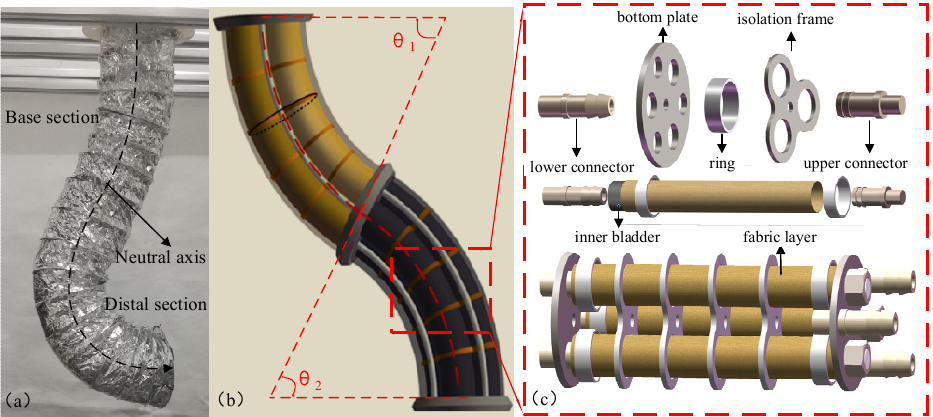
Figure 1. ( a ) Physical image of the soft manipulator. ( b ) Three-dimensional model of the soft manipulator. ( c ) Schematic diagram of the components of the soft manipulator.